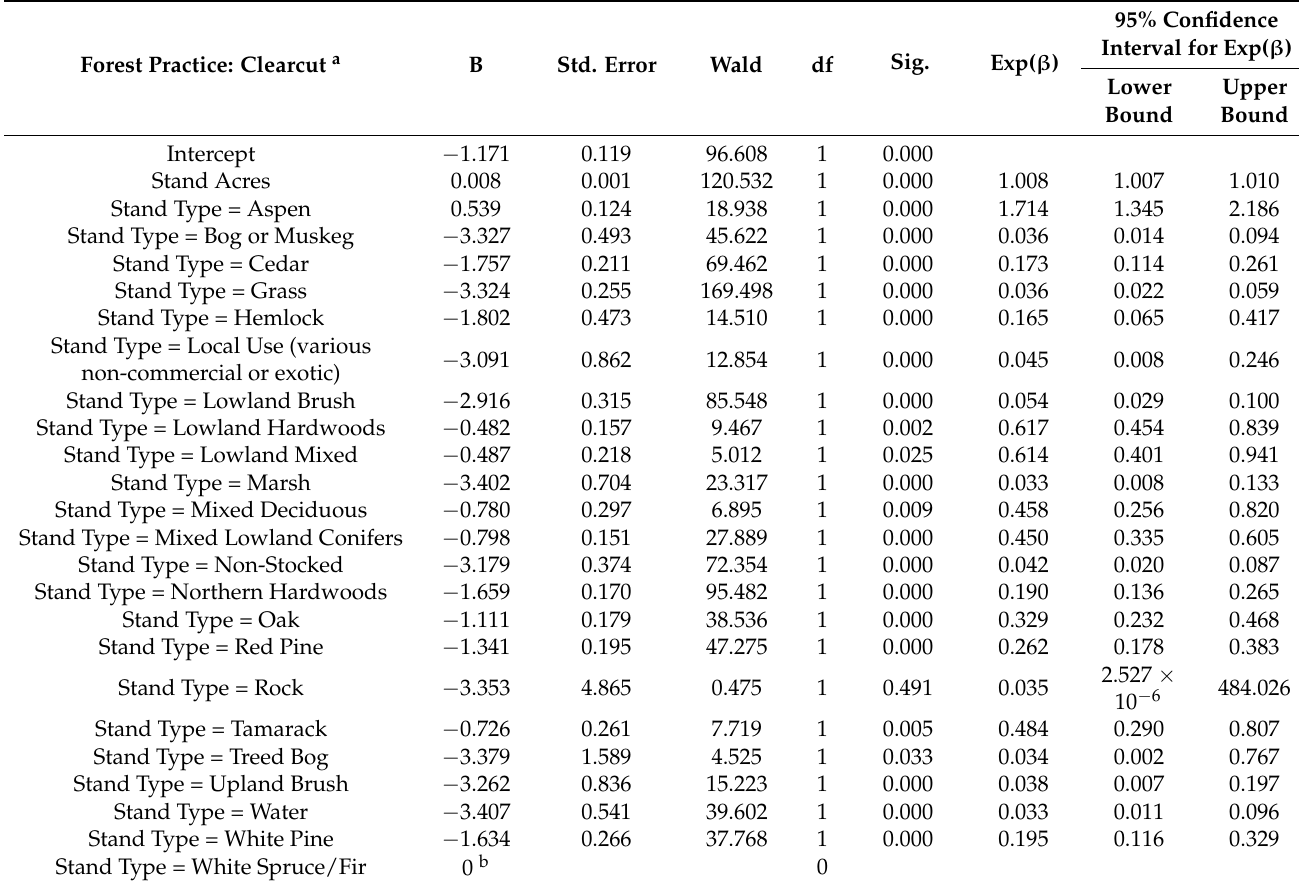
Table 3. Multinomial logistic regression parameter estimates for significant results predicting the forest practice “Clearcut.” Stand acres and stand type as independent variables (showing results from clearcut). N = 20,915 unique forest stands enrolled in the Qualified Forest